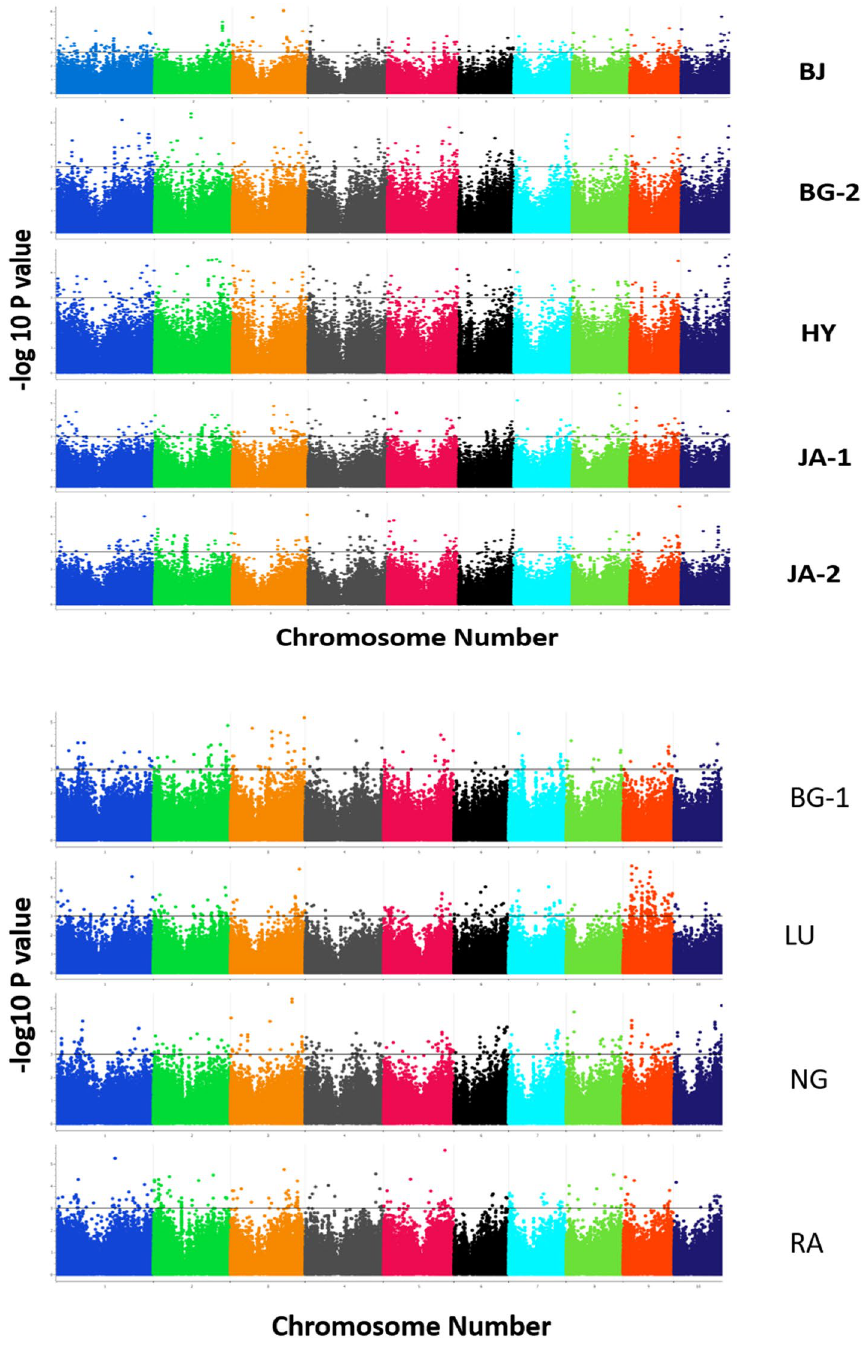
Figure 3. Genome-wide association analysis and significant marker-trait associations for grain yield under heat stress at different phenotyping